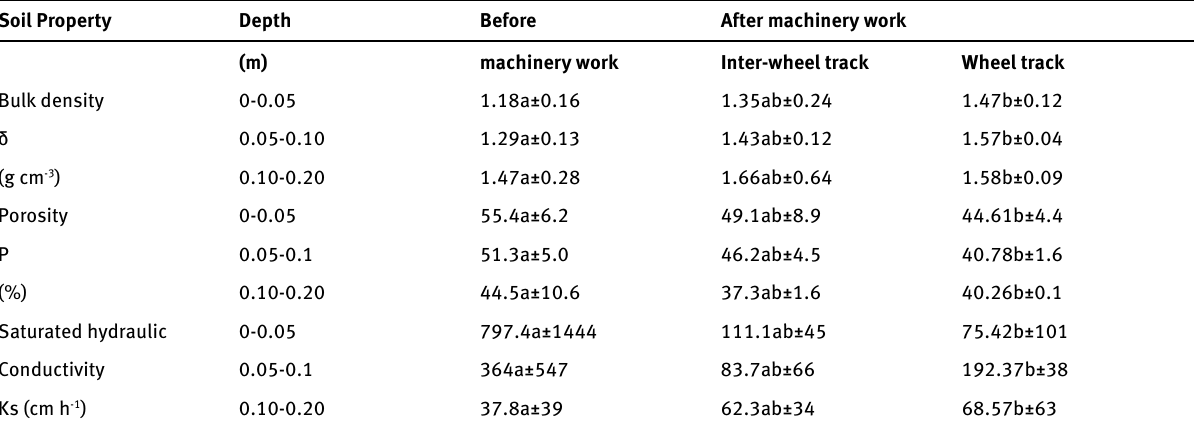
Table 1: Average values (± standard deviation) of the studied soil properties for the conditions before and after tilling and tractor passing obtained at and between the wheel tracks. Measuring depths are also